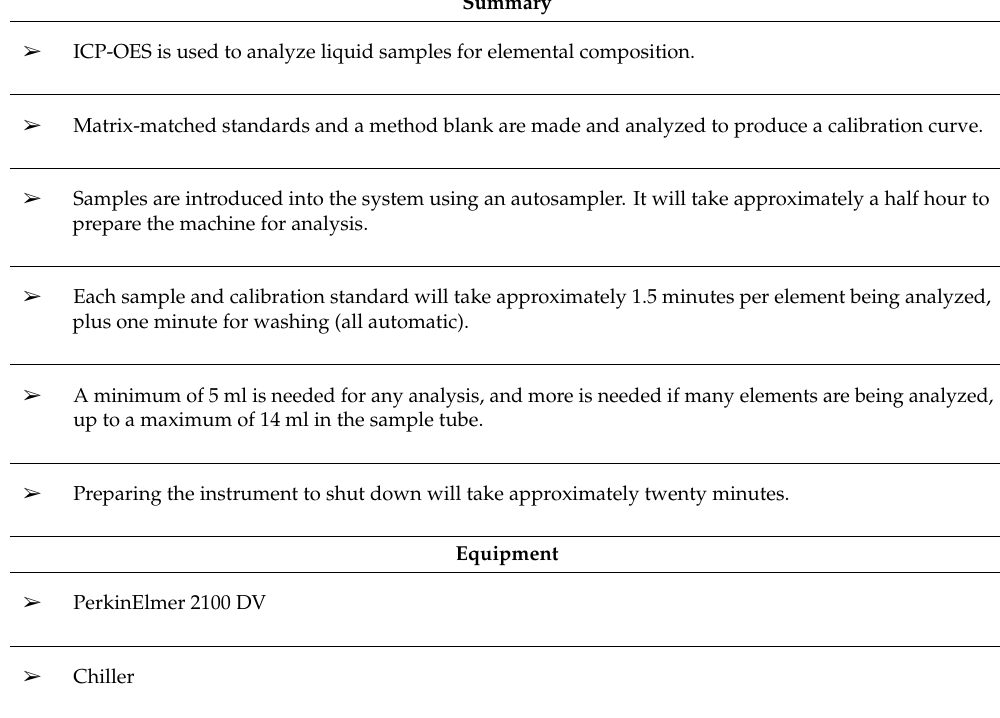
Table A2. Inductively coupled plasma-optical emissions spectroscopy protocols for Central Analytical Laboratory, Oregon State University, Corvallis, OR, USA. Summary